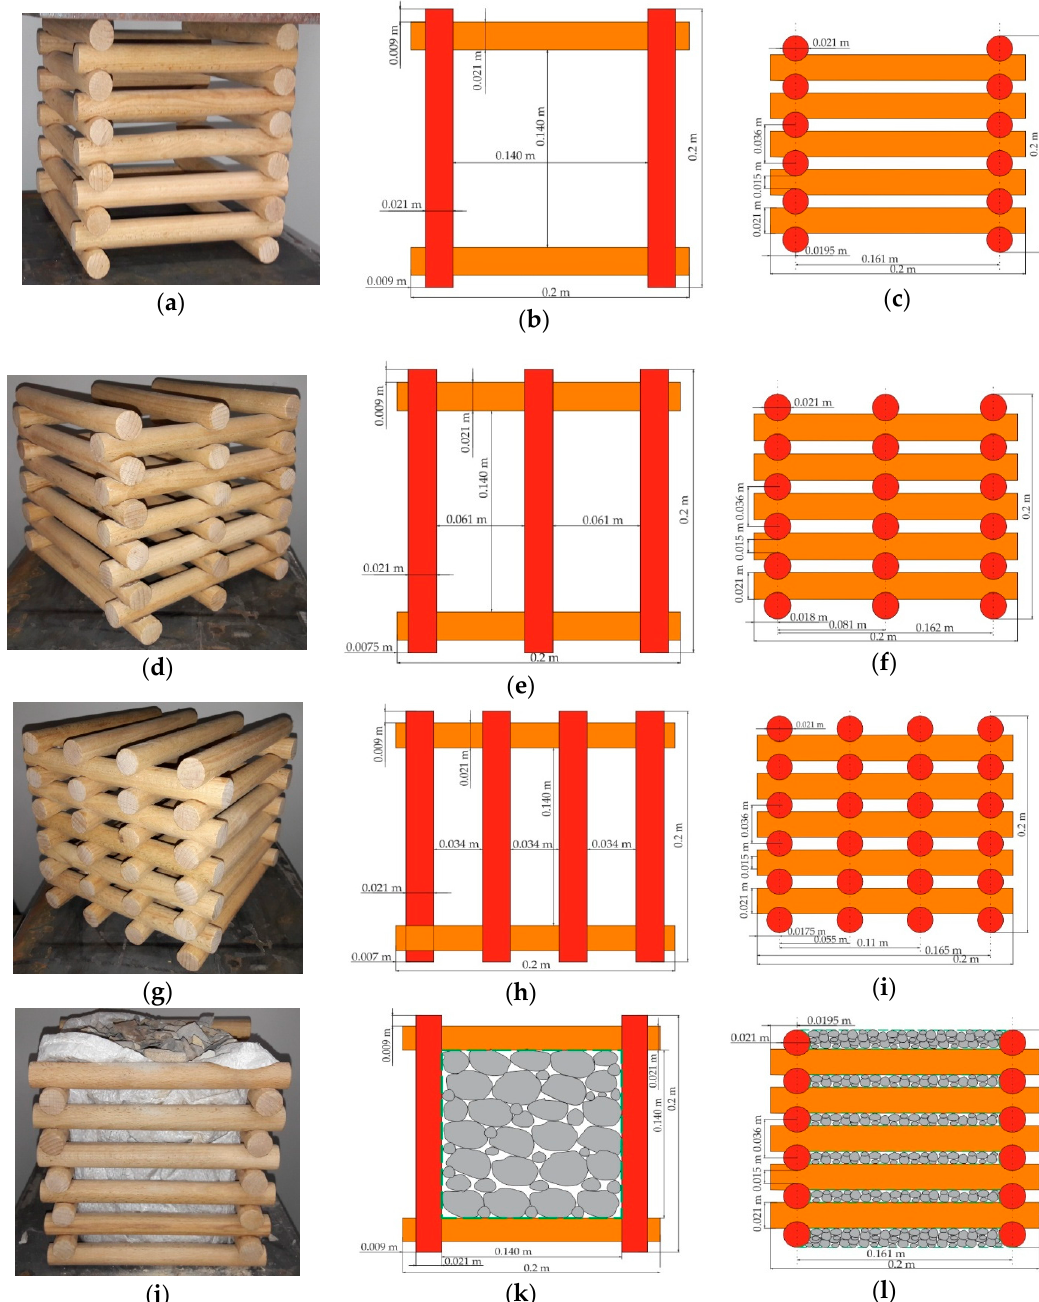
Figure 6. Multi-point cribs: ( a ) Four-point, general view; ( b ) Four-point, top view; ( c ) Four-point, side view; ( d ) Six-point, general view; ( e ) Six-point, top view; ( f ) Six-point, side view; ( g ) Eight-point, general view; ( h ) Eight-point, top view; ( i ) Eight-point, side view; ( j ) Four-point filled with waste rocks, general view; ( k ) Four-point filled with waste rocks, top view; ( l ) Four-point filled with waste rocks, side view.